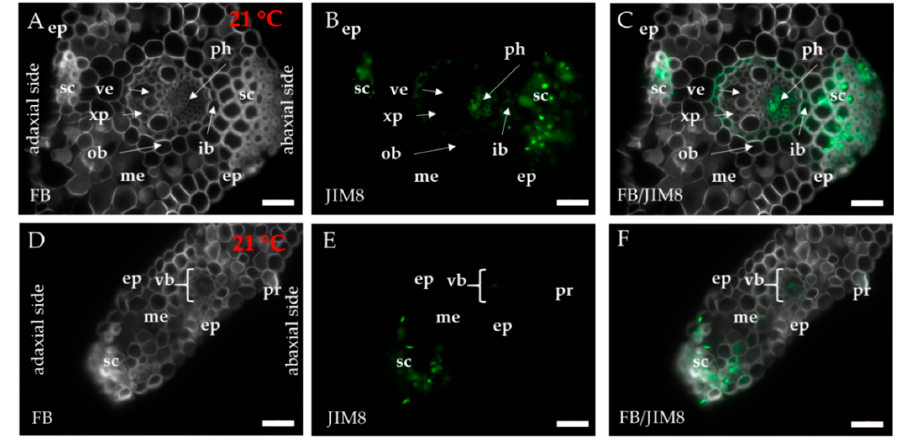
Figure A1. Immunolocalisation of the JIM8 epitope ( A – F ) in cross ‐ sections of B. distachyon leaves (21 °C), ( A – C ): through the major vascular bundle; ( D – F ): through the edge of the leaf blade. The white arrows point to the respective parts of the leaf. Abbreviations: ep—epidermis, FB—fluorescent brightener, ib—inner bundle sheath, me—mesophyll, ob—outer bundle sheath, ph—phloem, pr—prickle, sc—sclerenchyma, vb—vascular bundle, ve—vessels, xp—xylem parenchyma. The green colour shows epitope occurrence. Scale bars: 20 μ m.